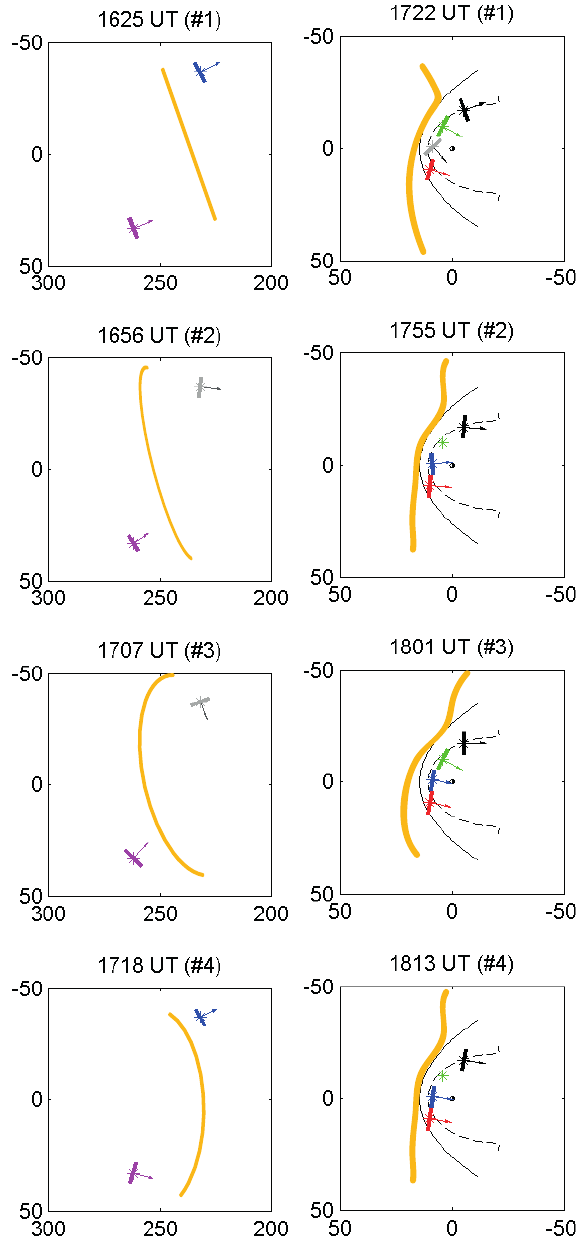
Fig. 3. Left column: the location of ACE (blue) and Wind (ma- genta) and the minimum variance direction of the magnetic field ro- tations as arrows and the tangential plane in the XY-plane. The yel- low curve shows an interpretation of the spatial shape of the fronts moving with the solar wind and should only be used as a guide. Right column: the location of Cluster (black), Geotail (green) Dou- bleStar TC1 (blue) and THEMIS (red) in the XY-plane, with the average location of the bow shock (solid black) and magnetopause (dashed black) taken from Fairfield (1971) and the yellow curve shows how the draping of the solar wind over the magnetopause can look like. Spacecraft labeled in grey indicate an ill-defined normal